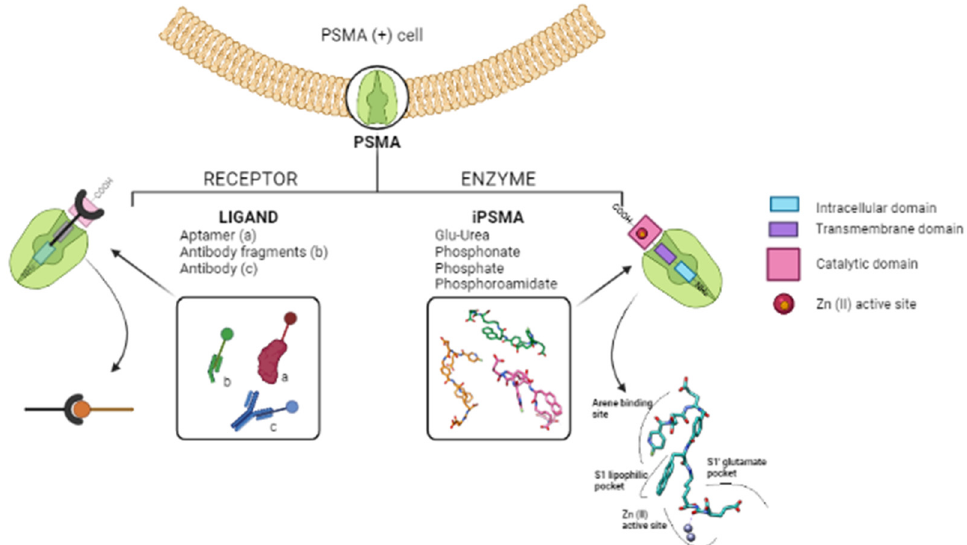
Figure 2. Graphical representation of the dual nature of PSMA biomarker. PSMA consists of three domains: an intracellular domain with 18 amino acids (light blue), a transmembrane region with 24 amino acids (purple), which inserts into the phospholipid bilayer, and a catalytic domain in which there are 707 amino acids (pink) containing the active site with two zinc ions. On the right side, it is possible to appreciate the zoom of the cavity of the active site with a generic PSMA-i ligand in which the portions of the inhibitor that interact with specific entities of the receptor pocket are highlighted (created in BioRender).